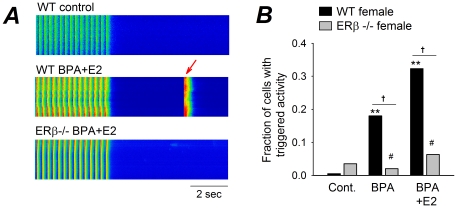
Rapid effects of estrogens in female mouse myocytes are mediated by ERβ signaling.(A) Representative recordings of Ca transients elicited by repeated pacing from WT female mouse myocytes under control and in the presence of BPA plus E2 (both 10−9 M), and from female ERβ knockout (KO) myocytes in the presence of BPA plus E2. Arrow indicates spontaneous Ca transient. (B) Percentages of myocytes with triggered activities under control, 10−9 M BPA, and BPA plus E2, both 10−9 M. N = 57–86. #: P>0.1; **: P<0.01 vs. control in a χ2 test; †: P<0.01. P>0.1 for WT vs KO under control condition, and among the three groups (control, BPA and BPA + E2) for KO cells.